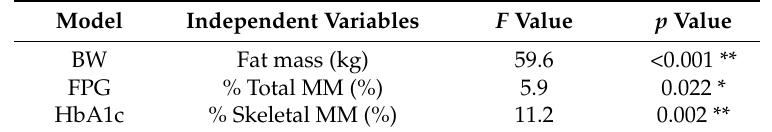
Table 2. Multiple stepwise regression models with ∆ BW, ∆ FPG, and ∆ HbA1c as dependent valuables.